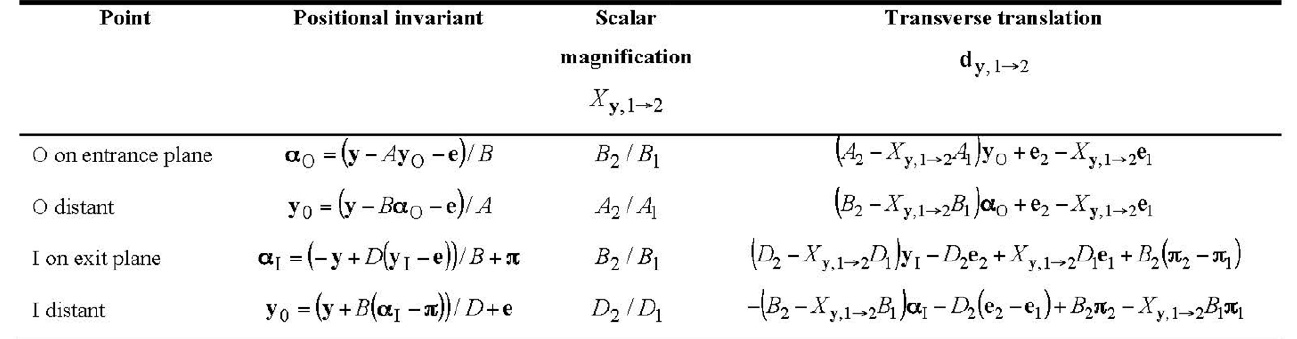
Table 1 Positional invariant along a ray through an object (O) or image (I) point and scalar magnification X translation d of transverse position y from transverse plane T y ,1 → 2